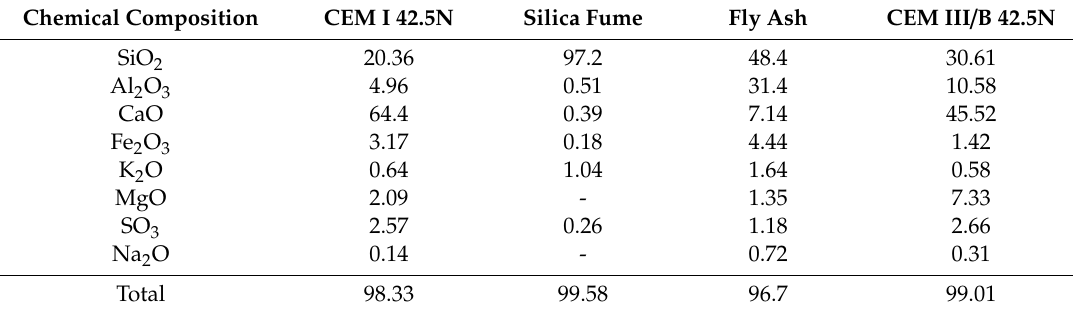
Table 2. Chemical composition of materials (% by